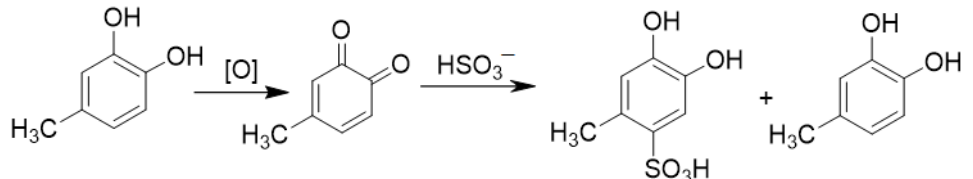
Figure 3. The oxidation of 4-methylcatechol by a generic oxidant, followed by reduction with and addition by sulfur dioxide, reversing the process of oxidation.